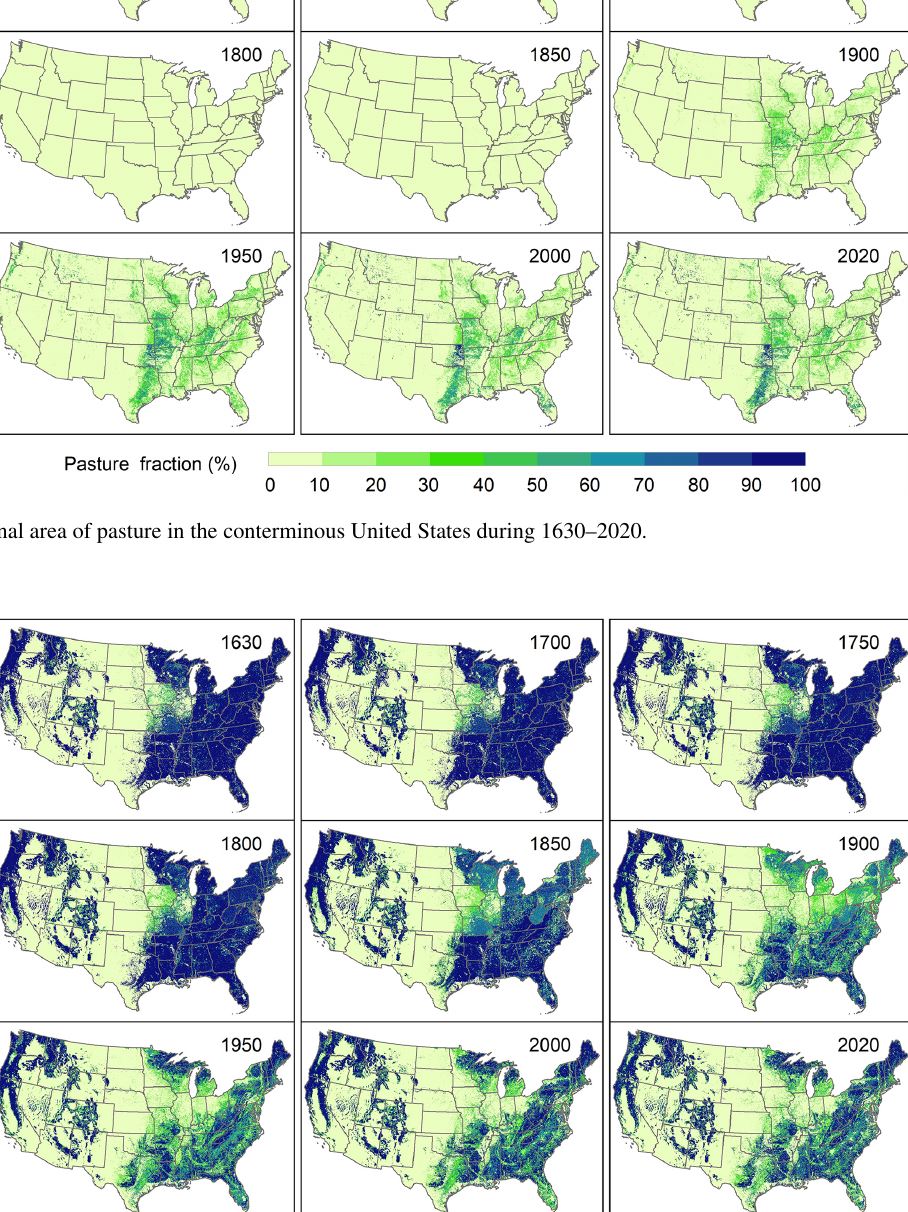
https://doi.org/10.5194/essd-15-1005-2023 Earth Syst. Sci. Data, 15, 1005–1035,